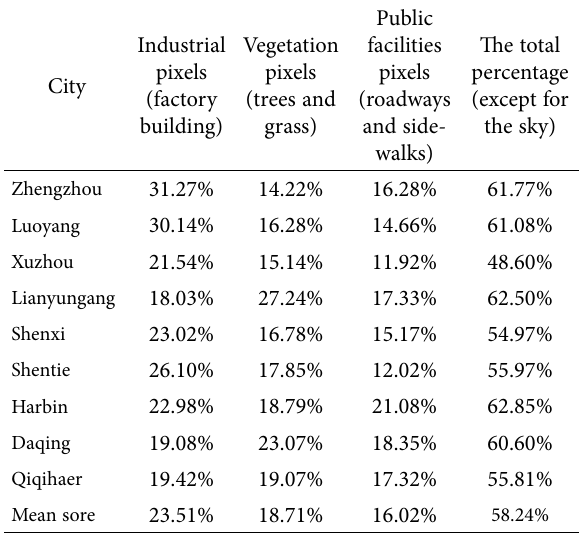
Table 1. Pixel proportion (percentage) of each landscape element of industrial corridors.